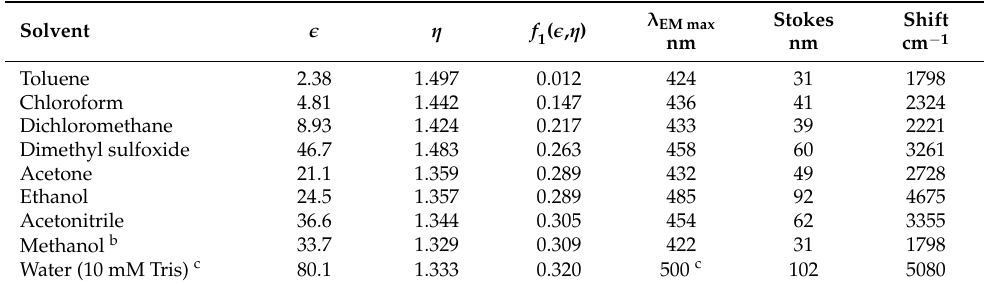
Table 2. Summary of Spectroscopic Properties of 5 as a Function of Solvent a